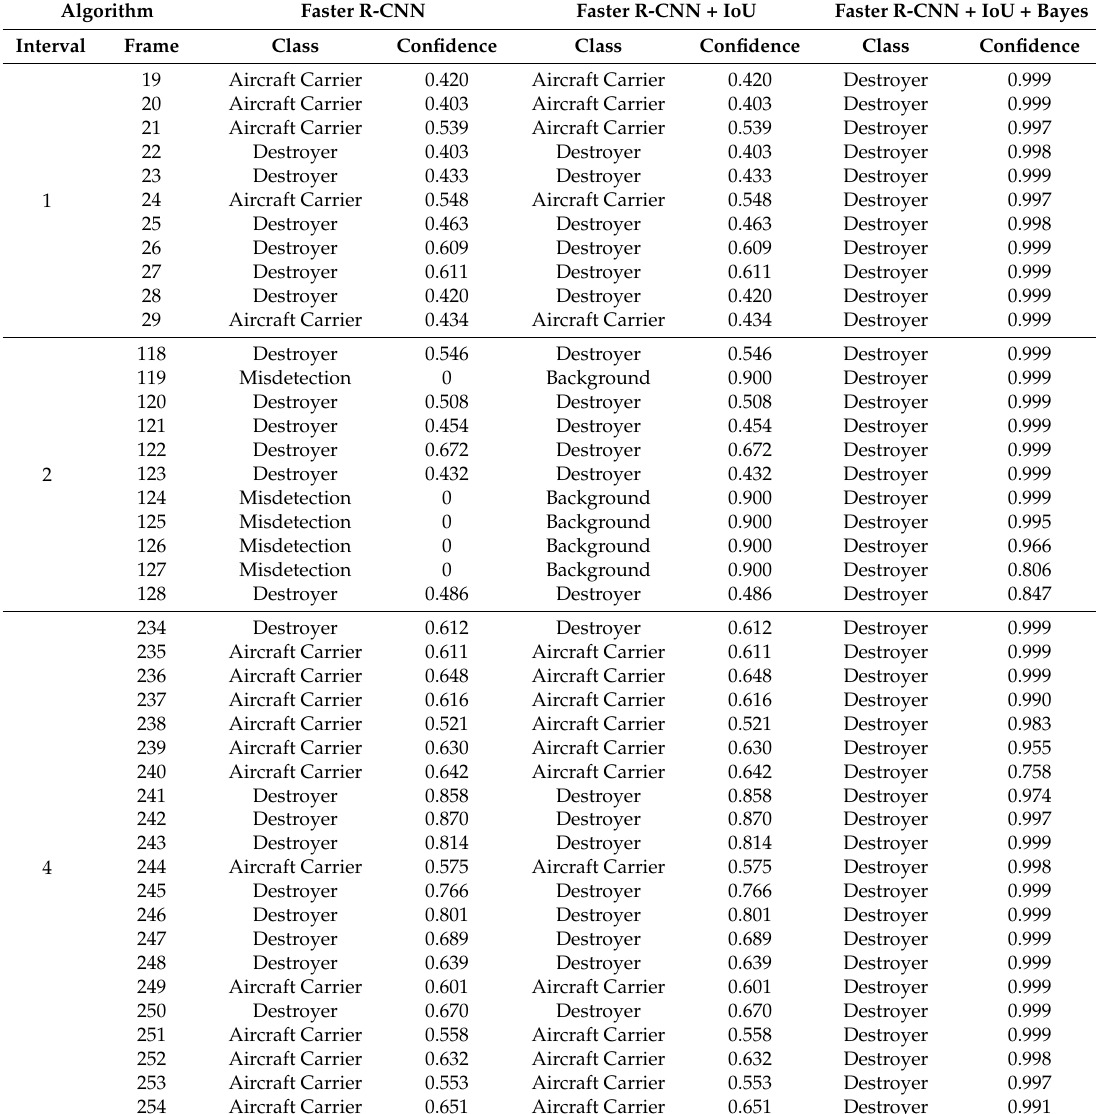
Table 4. The change of the class and the confidence of the